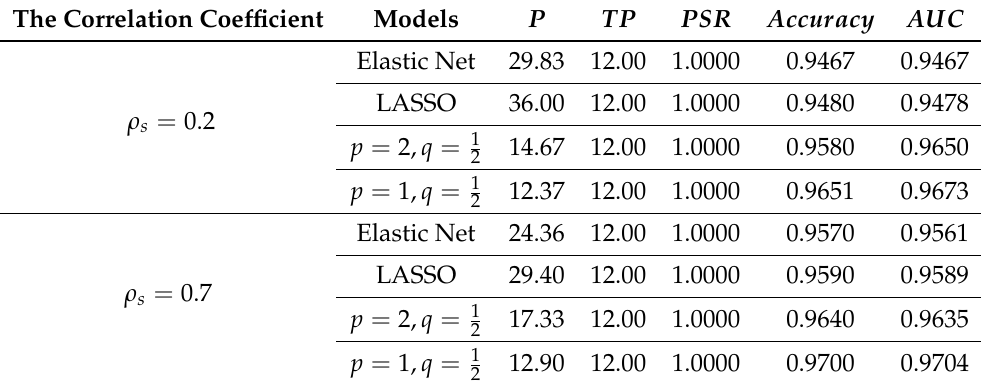
Table 2. The results for the simulations in experiment